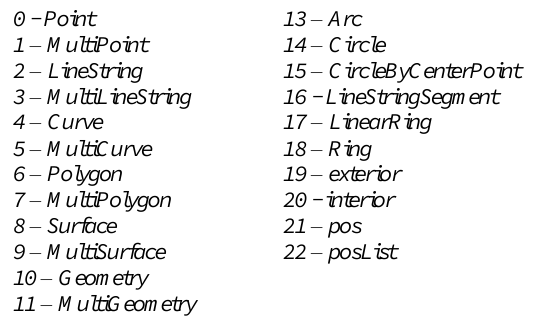
Figure 3. GML geometry tags available in SFP